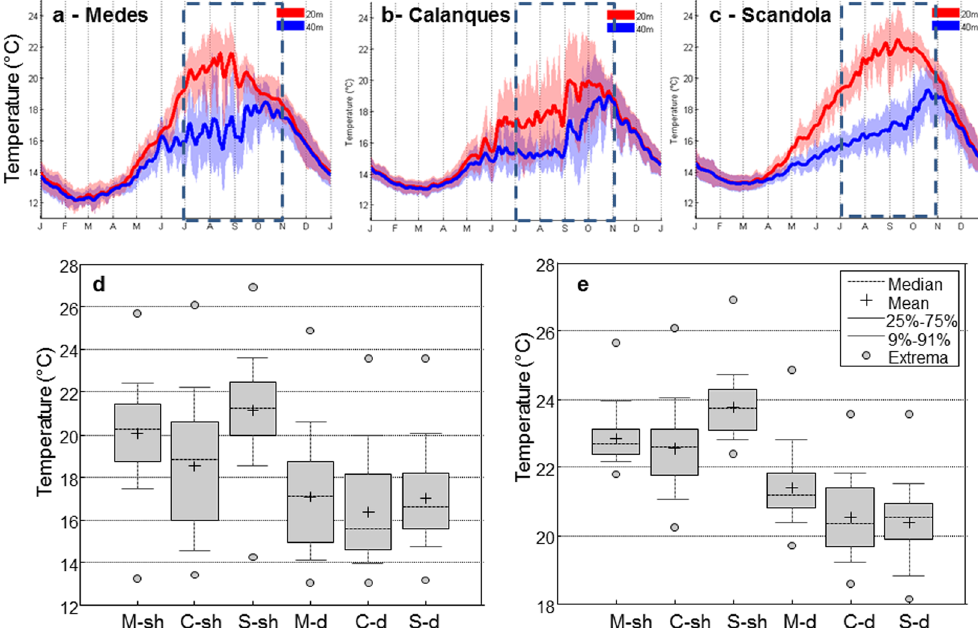
Figure 2. Temperature regimes of the study localities. Average annual temperature cycle ( ± SD) at 20 and 40 m depth for Medes ( a ), Calanques (Calanques 1) ( b ) and Scandola. Boxplots of hourly temperature records (of all available years) considering the July to October period and boxplots considering only the 10% of the data with the highest temperature are presented in ( d ) and ( e ) respectively. M-sh and M-d: Medes shallow and deep respectively, C-sh and C-d: Calanques 1 shallow and Calanques 1 deep respectively, S-sh and S-d: Scandola shallow and deep